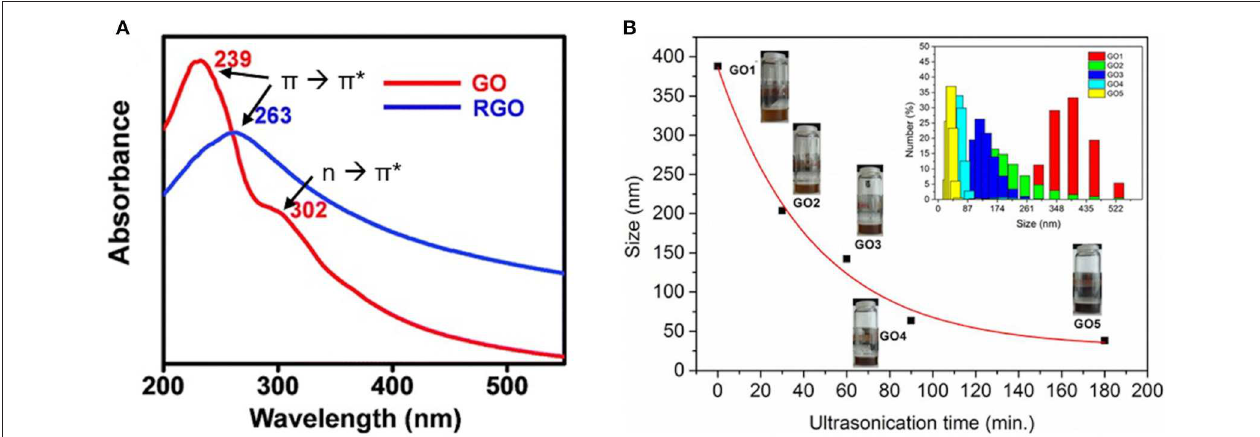
: : π * and reduction of n π *. (B) The DLS measurements of different GO flake sizes